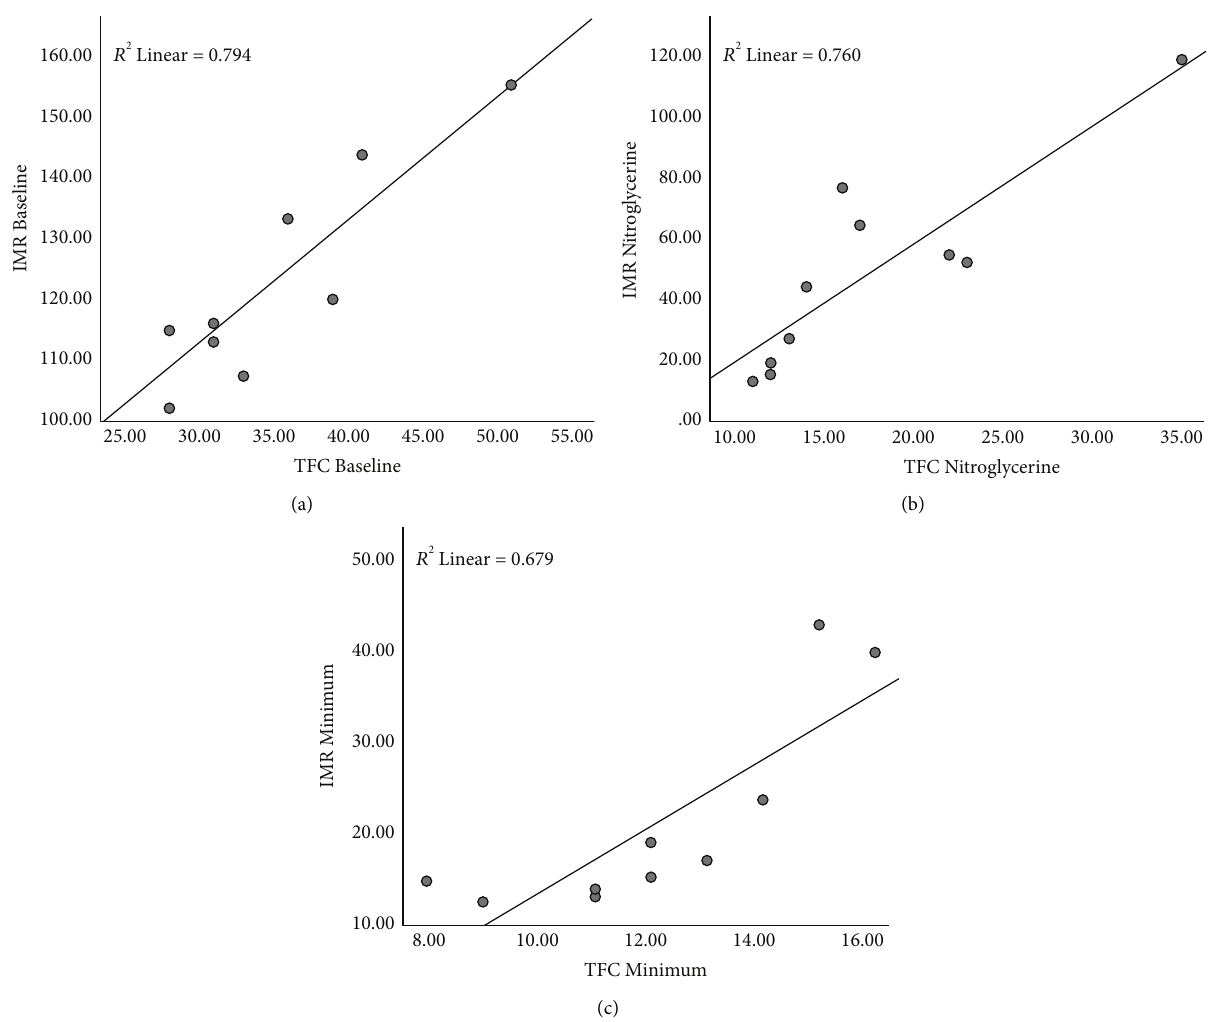
Figure 3: Correlation between IMR and TFC. (a) TFC significantly correlated with IMR Nit ( r � 0.875, P � 0 . 001). (c) TFC Min was significantly correlated with IMR Min ( r � 0.890, P � 0 .